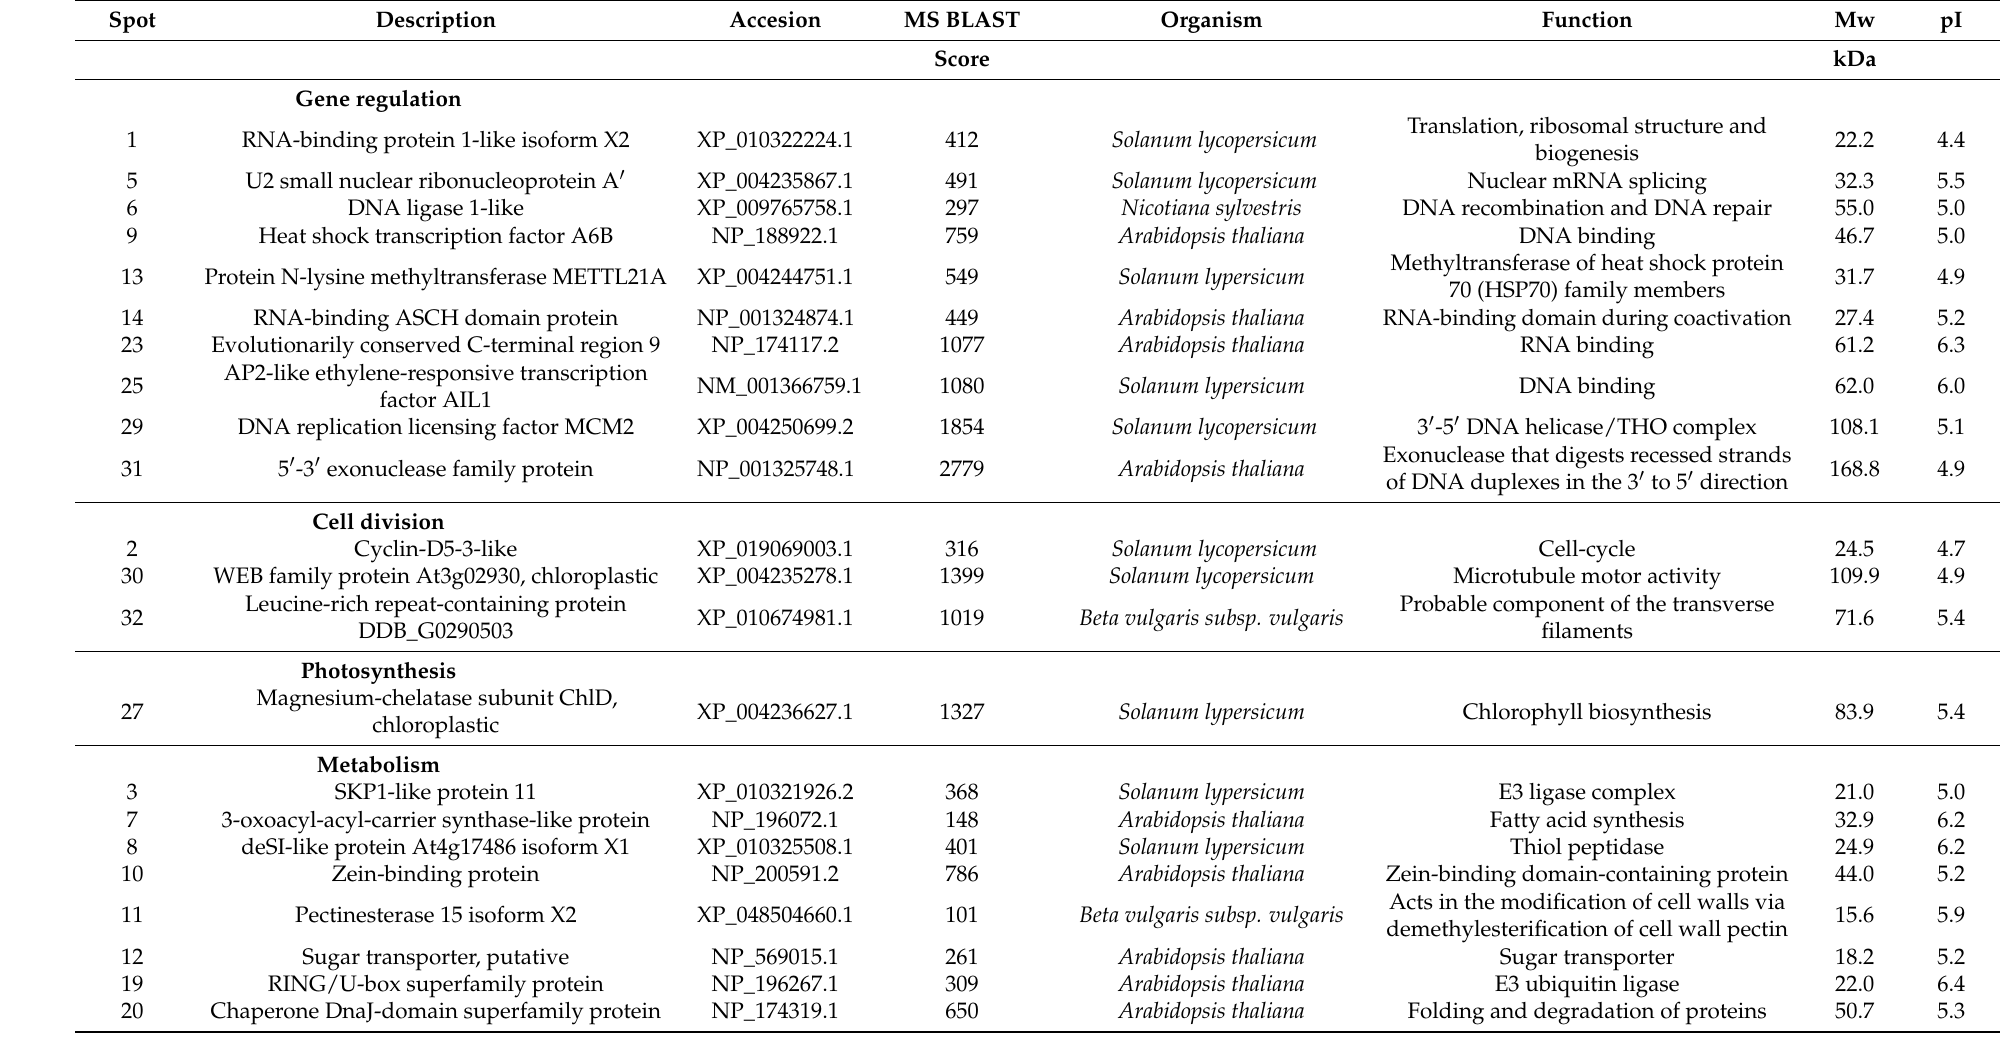
Table 1. Proteins detected in Psittacanthus calyculatus infective